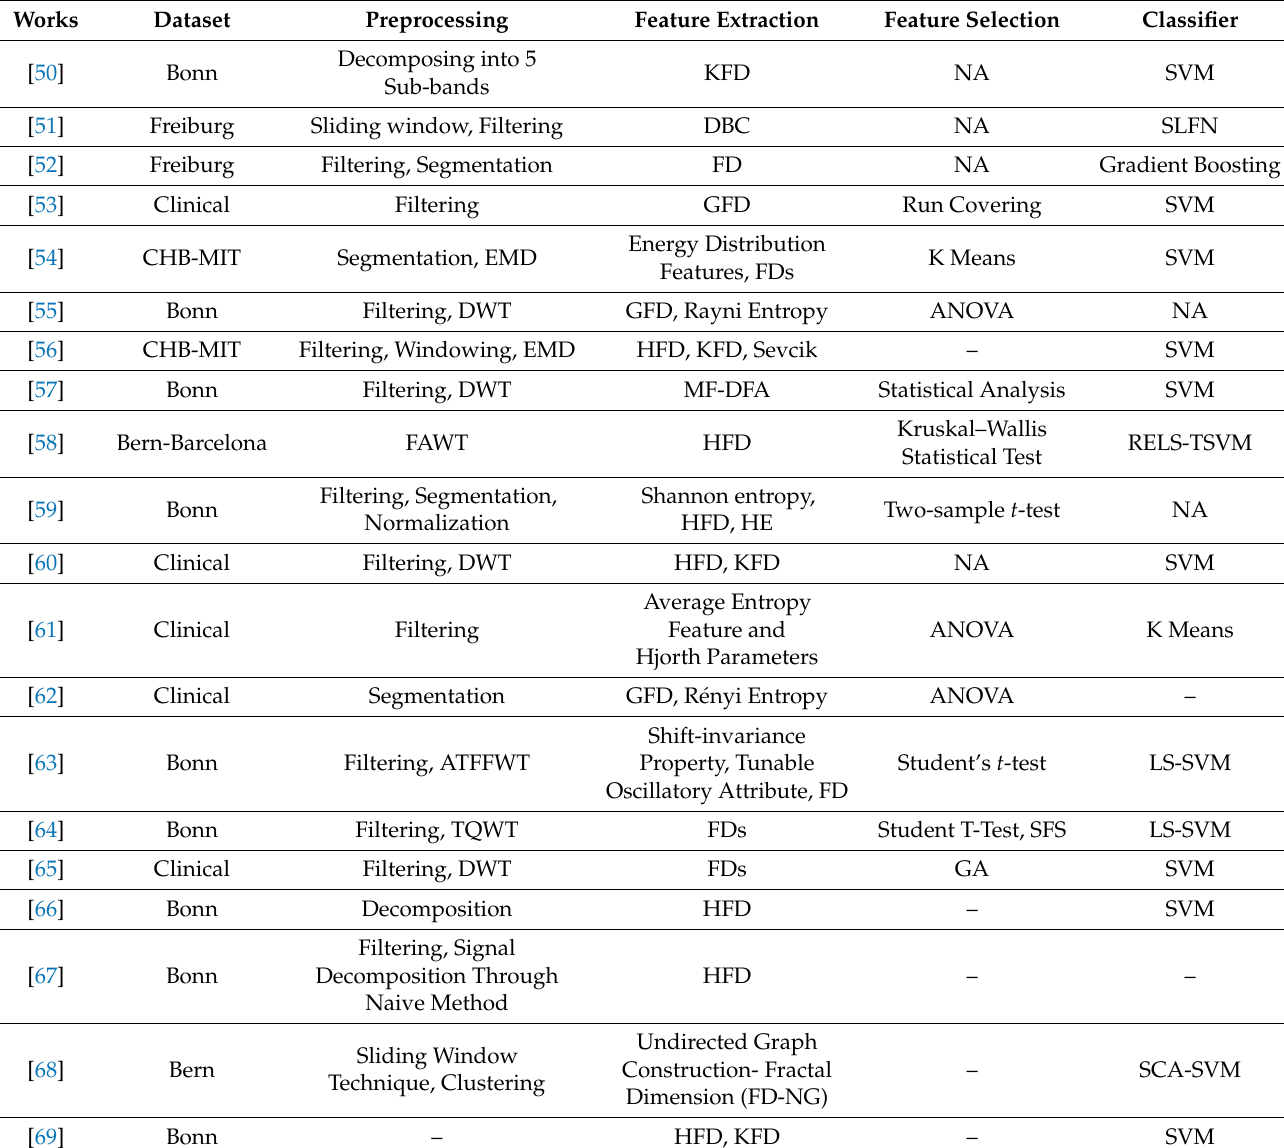
Table 1. Related works on diagnosis of epileptic seizures using FD